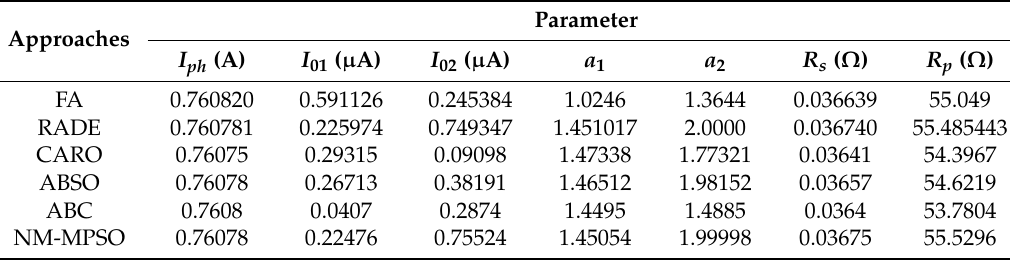
Table 4. Comparison of various parameter identification techniques for a double diode model (RTC France Company).